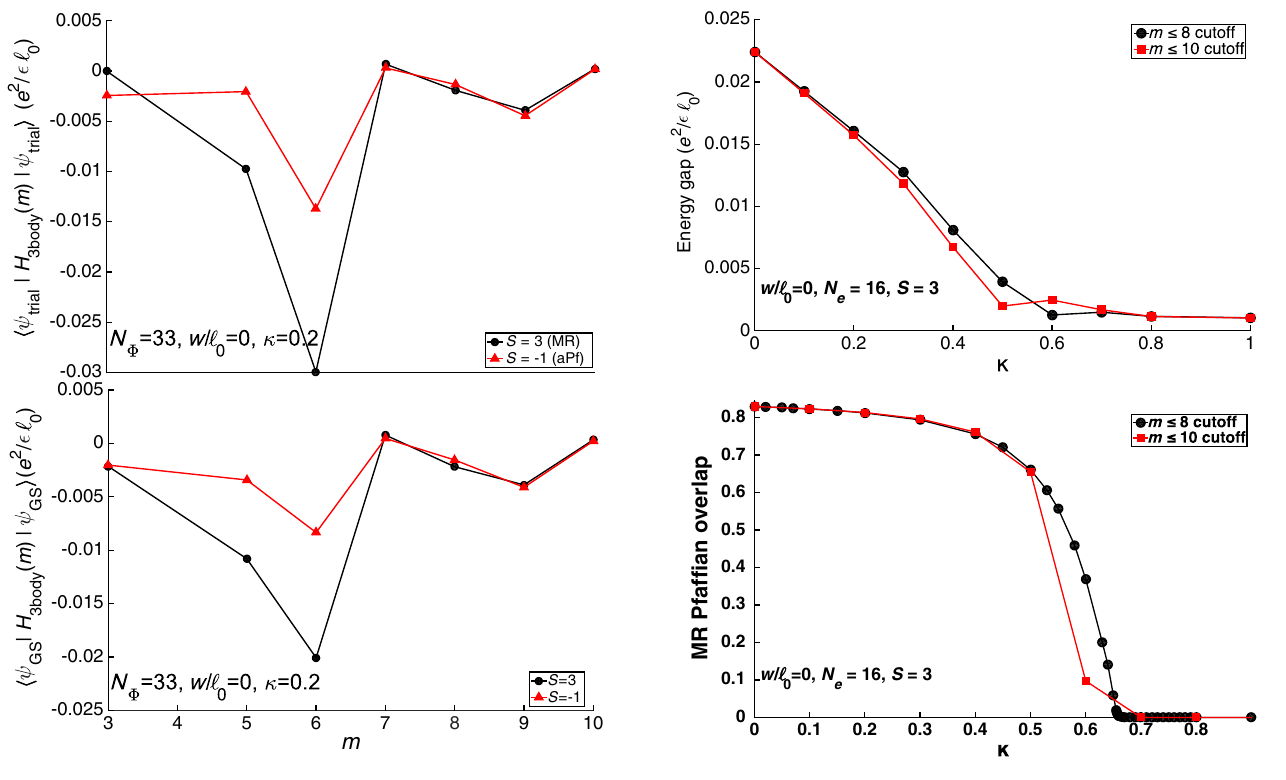
ð 3 Þ m with m ≤ 8 ð 3 Þ 9